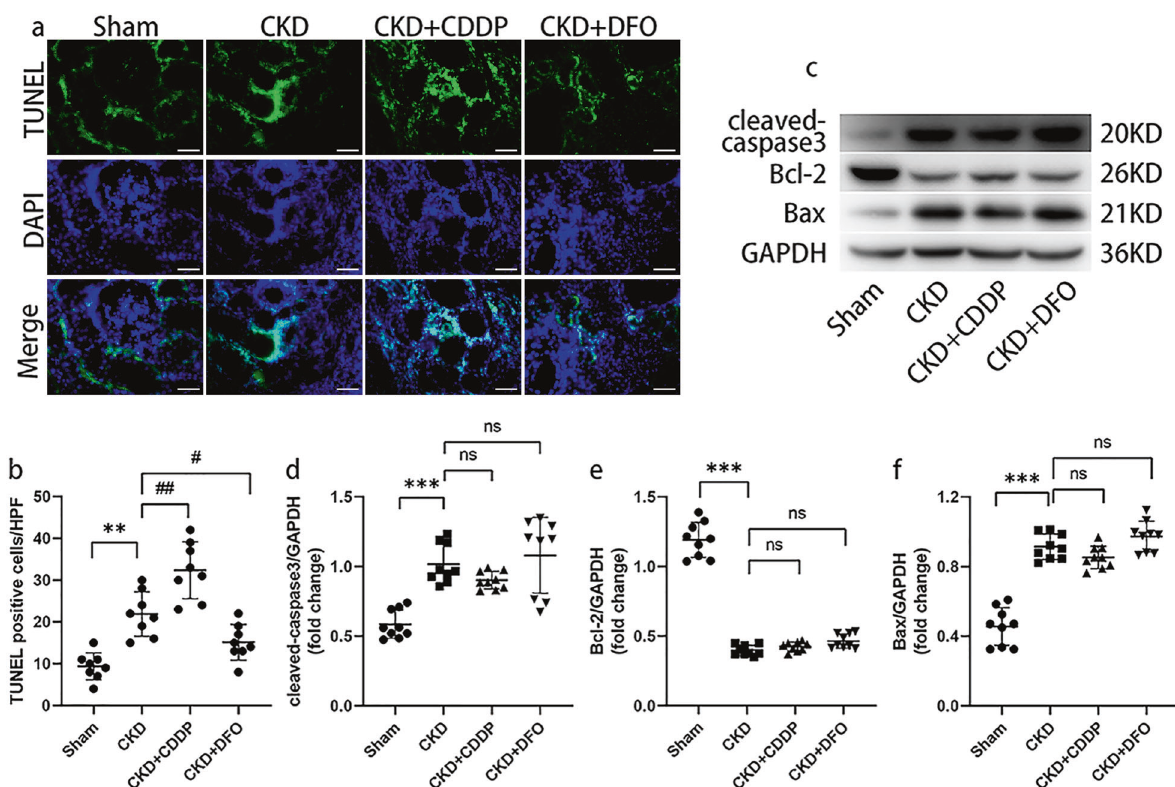
Fig. 3 CDDP and DFO affect 5/6 nephrectomy-induced ferroptosis, independent of apoptosis. CDDP and DFO affect 5/6 nephrectomy- induced ferroptotic cell death ( a , b ), rather than apoptosis ( c – f ). ** P < 0.01, *** P < 0.001 vs. Sham group; # P < 0.05, ## P < 0.01 vs. CKD group. ns: P > 0.05, no signi fi cance. Scale bar = 50 μ